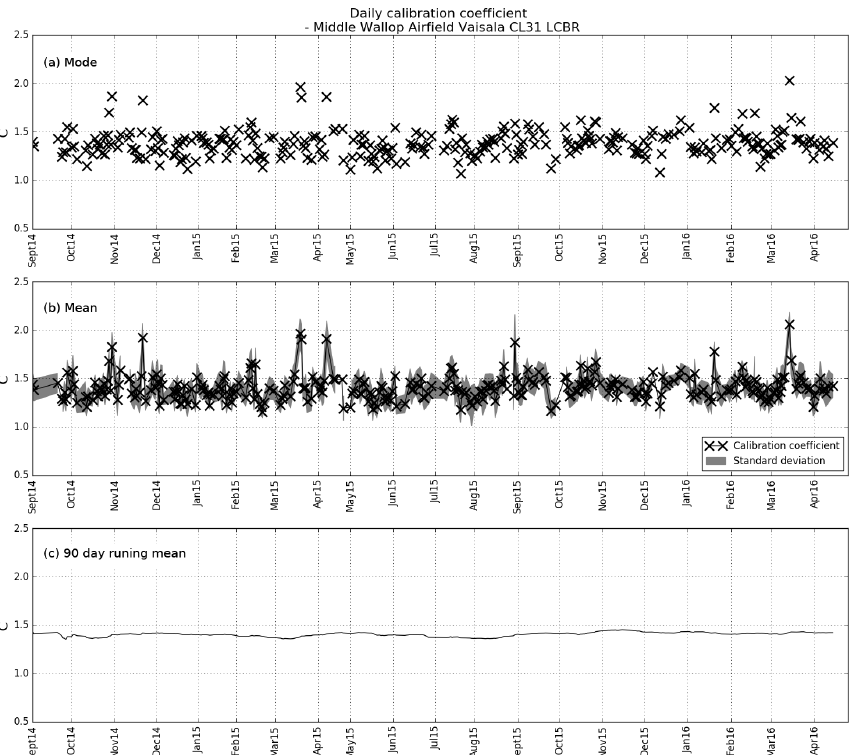
Figure 7. Calibration coefficient ( C ) for Middle Wallop CL31 from September 2014 to April 2016. Each black cross represents a single day, calculated from profiles deemed suitable by the calibration algorithm. Panel (a) shows the mode of C for each individual day, (b) shows the mean of C for each day, with the standard deviation shaded in grey and (c) shows a 90d running mean for the 20-month period. The average of the daily modes is 1 . 38 ± 0 . 14, the average of the daily means is 1 . 41 ± 0 . 13 and the average of the 90d running means is 1 . 40 ± 0 . 021. The water vapour absorption correction has been applied, without which there would be an annual cycle in the calibration of about